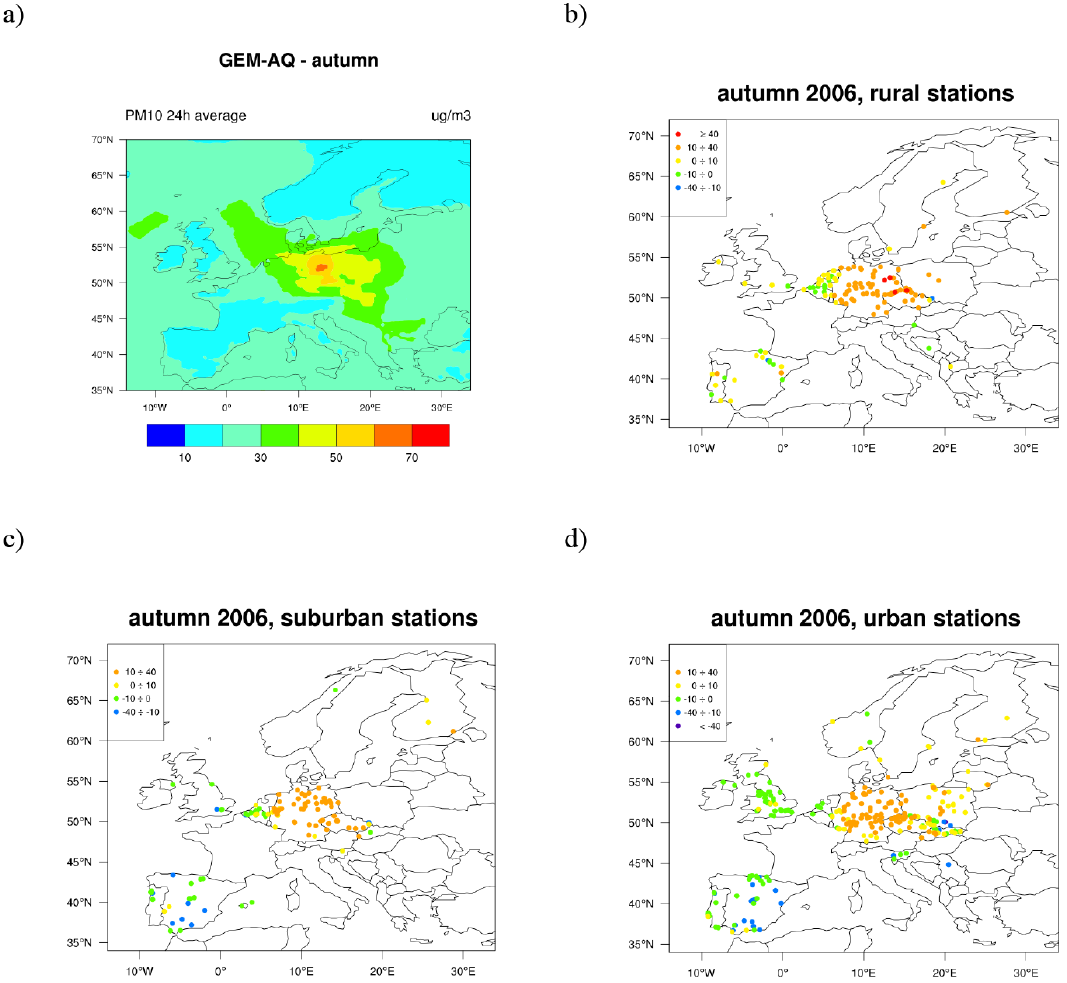
Figure 18. Autumn (SON) 24h average PM 10 concentrations in µgm − 3 (a) , MBE at rural stations (b) , MBE at suburban stations (c) and MBE at urban stations (d)